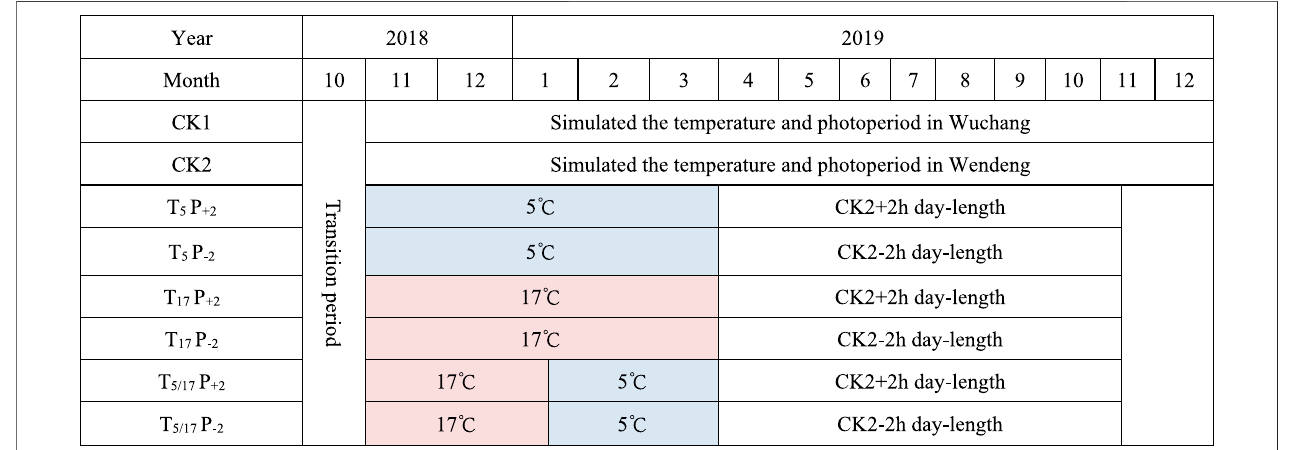
FIGURE 2 | Schematic diagram of experimental schedule and treatment timing in cabinet experiments. Note: CK1, simulated the temperature and photoperiod in Wuchang; CK2, simulated the temperature and photoperiod in Wendeng; T 5 P +2 , temperature during dormancy is 5 ° C, day-length during growth period is natural day- length in Wendeng +2 h; T 5 P -2 , temperature during dormancy is 5 ° C, day-length during growth period is natural day-length in Wendeng − 2 h; T 17 P +2 , temperature duringdormancyis17 ° C,day-lengthduringgrowthperiod isnaturalday-lengthinWendeng+2 h;T 17 P -2 ,temperatureduringdormancyis17 ° C,day-lengthduring growth period is natural day-length in Wendeng − 2 h; T 5/17 P +2 , temperature during dormancy is 5/17 ° C, day-length during growth period is natural day-length in Wendeng +2 h; T 5/17 P -2 , temperature during dormancy is 5/17 ° C, day-length during growth period is natural day-length in Wendeng − 2